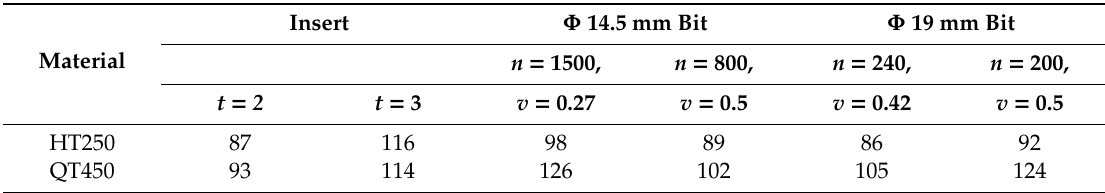
Table 4. The insert and bit temperature in ◦ C.